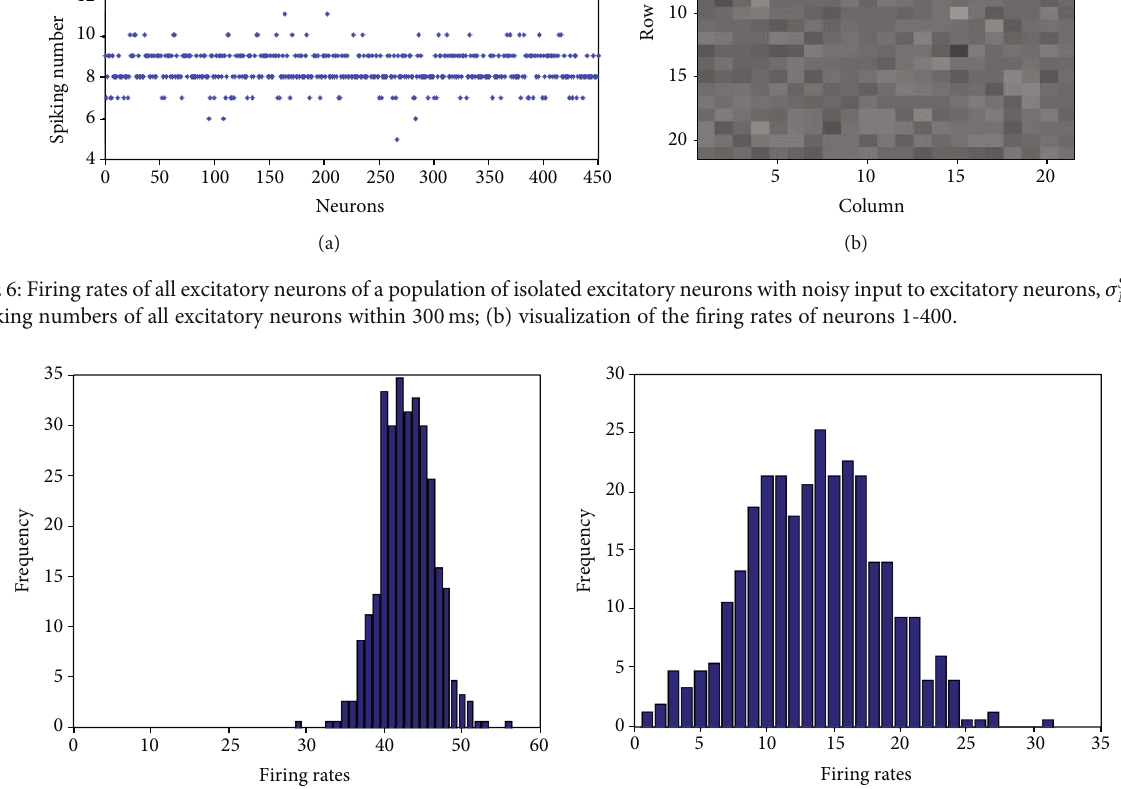
Figure 7: Histograms of the fi ring rates of all excitatory neurons in (a) a population of isolated excitatory neurons with noisy input and (b) E/I networks with noisy